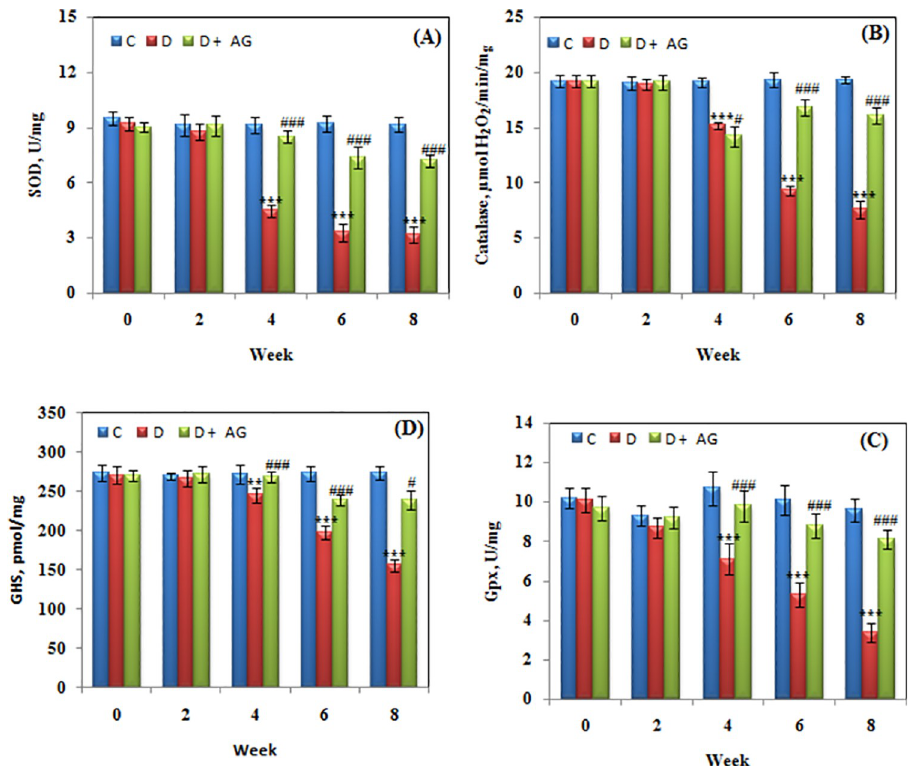
Fig 3. Antioxidant biomarkers of alloxan-diabetic rabbits treated for 8 weeks with aminoguanidine. Activities of SOD ( A ), Catalase ( B ), Gpx ( C ), and level of glutathione ( D ). Values are mean ± SD, (n = 6 rabbits/group). ��� Significant difference (p < 0.0001) as compare to control. #,### Significant difference (p < 0.01, p < 0.0001) as compare to diabetic rats.